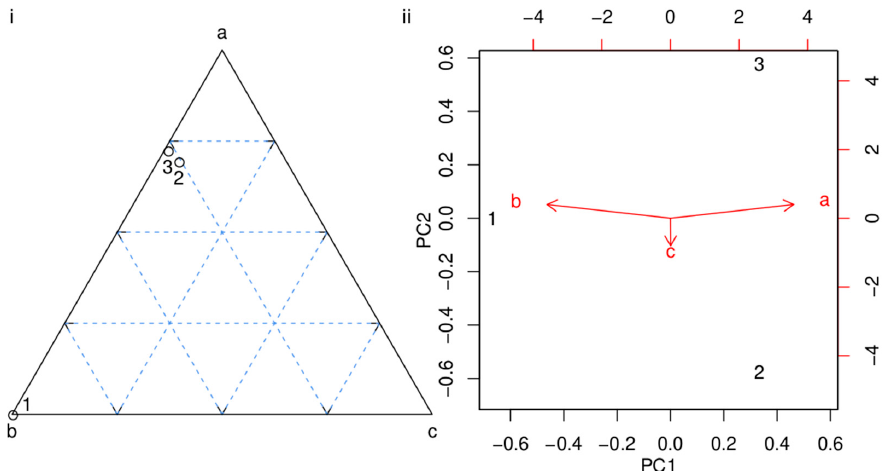
Figure 5. ( i ) the compositional dataset of Equation (14) shown on a ternary diagram; ( ii ) principal Figure 5. ( i )—the compositional dataset of Equation (14) shown on a ternary diagram; ( ii )—principal component biplot of the same data after centred logratio (clr) transformation. component biplot of the same data after centred logratio (clr)